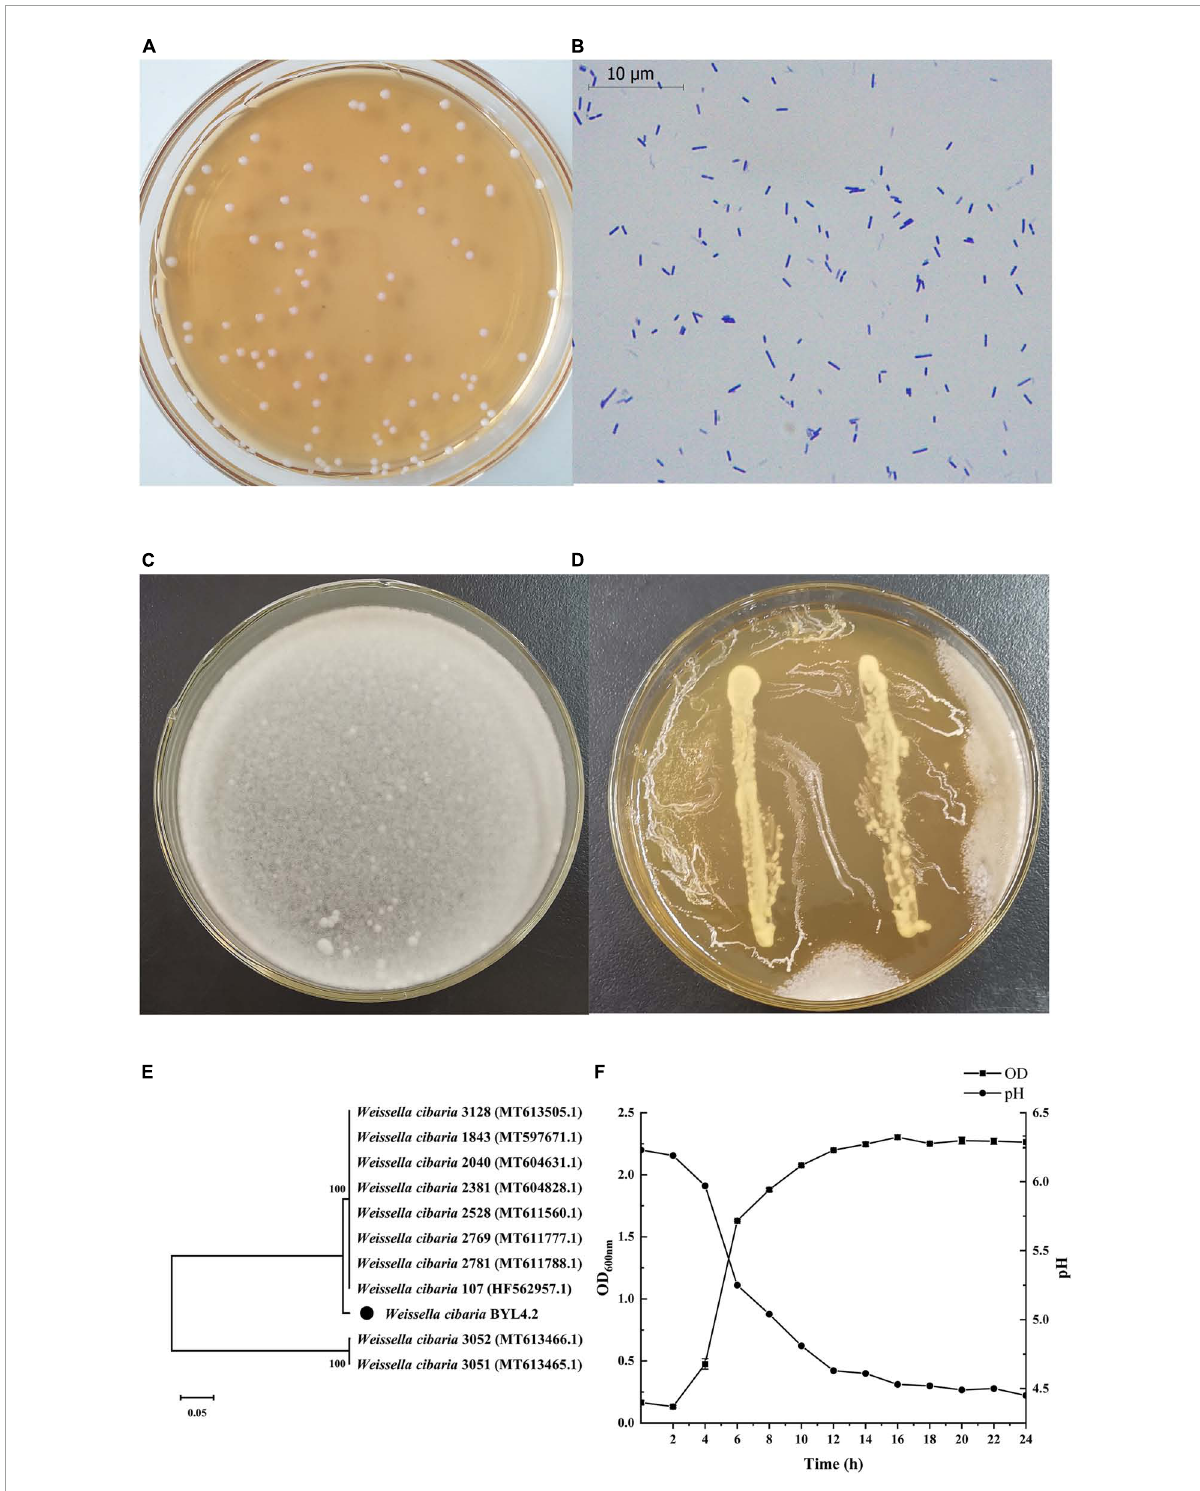
FIGURE1 Identification and screening of antifungal LAB. The colony picture (A) and microscopic picture ( × 1,000) (B) of LAB isolates. Inhibition of Penicillium chrysogenum by Weissella cibaria BYL4.2 by agar overlay method after 3 day incubation at 28 ◦ C. Control P. chrysogenum (C) . W. cibaria BYL4.2 (D) overlaid by P. chrysogenum . Phylogenetic tree analysis of W. cibaria BYL4.2 using the neighbor-joining algorithm. The numbers above the branches are confidence limits expressed as percentages. The scale bar represents 0.05% sequence divergence (E) . Growth kinetics (square) and acidification profile (circle) of W. cibaria BYL4.2 in MRS broth at 37 ◦ C for 24 h (F)